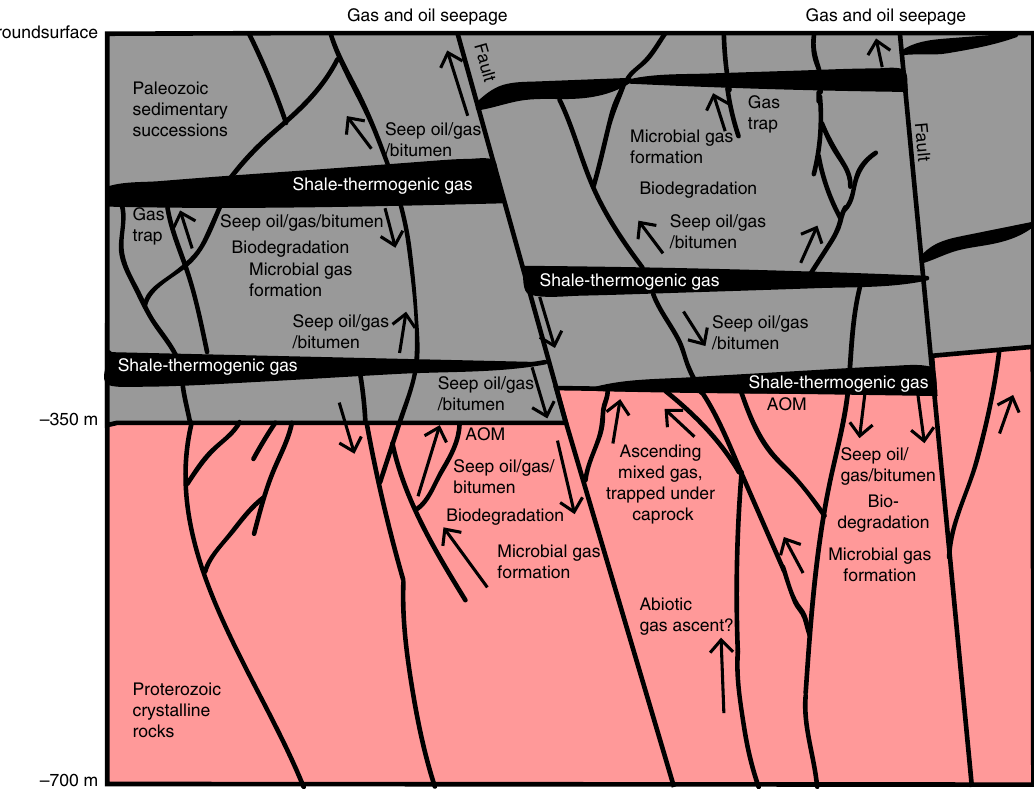
Fig. 8 Conceptual model of the gas accumulation in the Siljan ring impact structure. Thermogenic gas formed in the (to varying degree) mature Silurian and Ordovician black shales in the sedimentary strata. This gas and related seep oil and bitumen dispersed in the adjacent sedimentary successions with local sur fi cial seepage. Downward migration of these hydrocarbons has occurred into the granitic basement during fracture reactivation events. Biodegradation of the hydrocarbons has occurred in the fracture system and secondary methane has formed in situ. The mixed gas, of microbial (dominantly) and biodegraded thermogenic type, which also may have an abiotic end-member, has accumulated at the sedimentary-granite contact where anaerobic oxidation of methane has